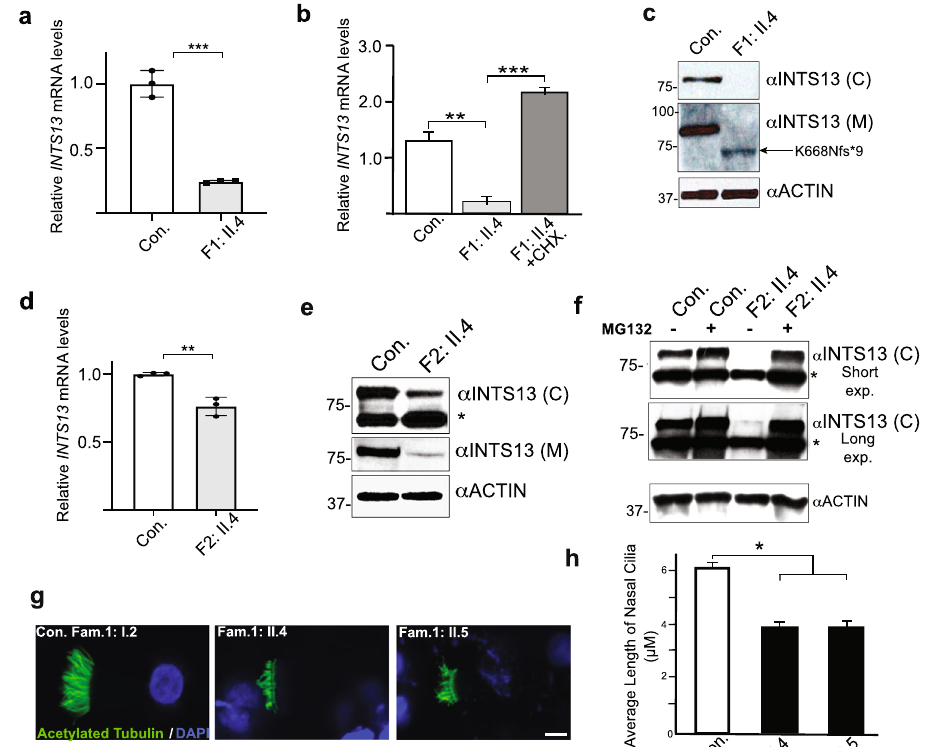
Fig. 2 | Characterization of INTS13 variants using patients ’ cells. a RT-qPCR shows that endogenous INTS13 transcriptlevelsweresigni fi cantly reducedrelative tocontrolcellsinprimarydermal fi broblastsofaffectedindividualII.4fromFamily 1. Data are mean+/- SD, n =3 replicate cell samples. Statistical signi fi cance was calculated using a two-tailed unpaired t -test. p =0.000223. b Primary dermal fi broblasts were treated with cycloheximide (CHX) (100g/ml). Following treat- ment,qRT-PCRwasdoneat8handshowsthat INTS13 mRNAlevelwasincreasedin treated cells indicating a non-sense mediated decay. Data are mean±s.e.m., * P <0.05; ** P <0.005; *** P <0.001; one-tailed Student ’ s t -test. c Western blot ana- lysisofprimarydermal fi broblastsofaffectedindividualII.4fromFamily1usingtwo polyclonal antibodies with antibody directed against the C-terminus of INTS13 (C) and the second antibodydirected against the centerofINTS13 (M). Actin wasused as a loading control and molecular weight markers shown are in kilodaltons. d RT- qPCR shows that INTS13 transcript levels were signi fi cantly reduced in primary dermal fi broblast cells of affected individual II.4 from Family 2 relative to control